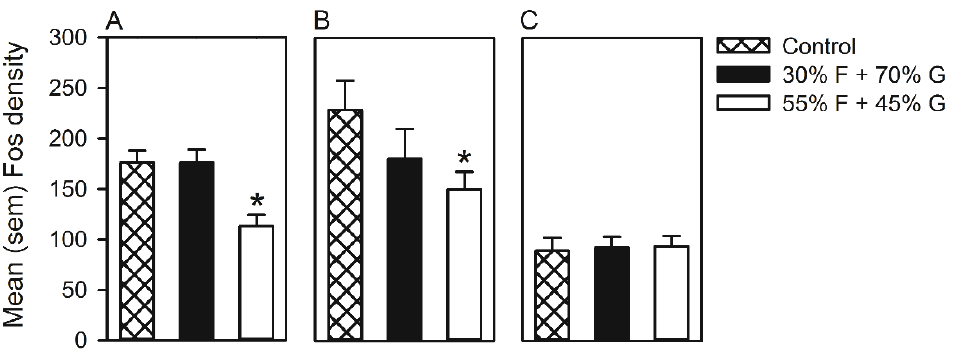
Figure 3. Mean (SEM) Fos density measured in the perifornical area of the hypothalamus ( A ), arcuate nucleus ( B ) and dorsomedial hypothalamus ( C ) of rats that self-administered 55% F + 45% G or 30% F + 70% G pellets. * Significant difference from the control